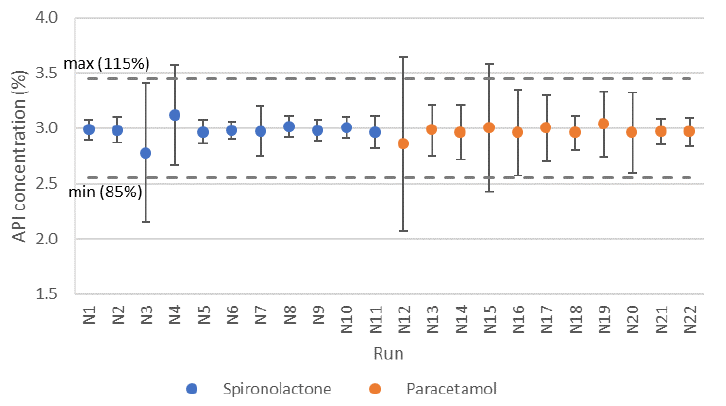
Figure 5. Calculated mean API concentration for each run with specification limits (85–115%).